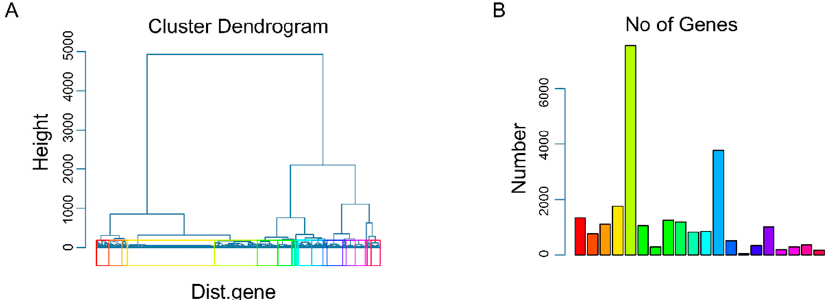
Figure 2. The result of gene clustering. ( A ) Divide genes into 20 groups as an important parameter for the construction of group lasso. ( B ) The number of genes in each group shown as a histogram.